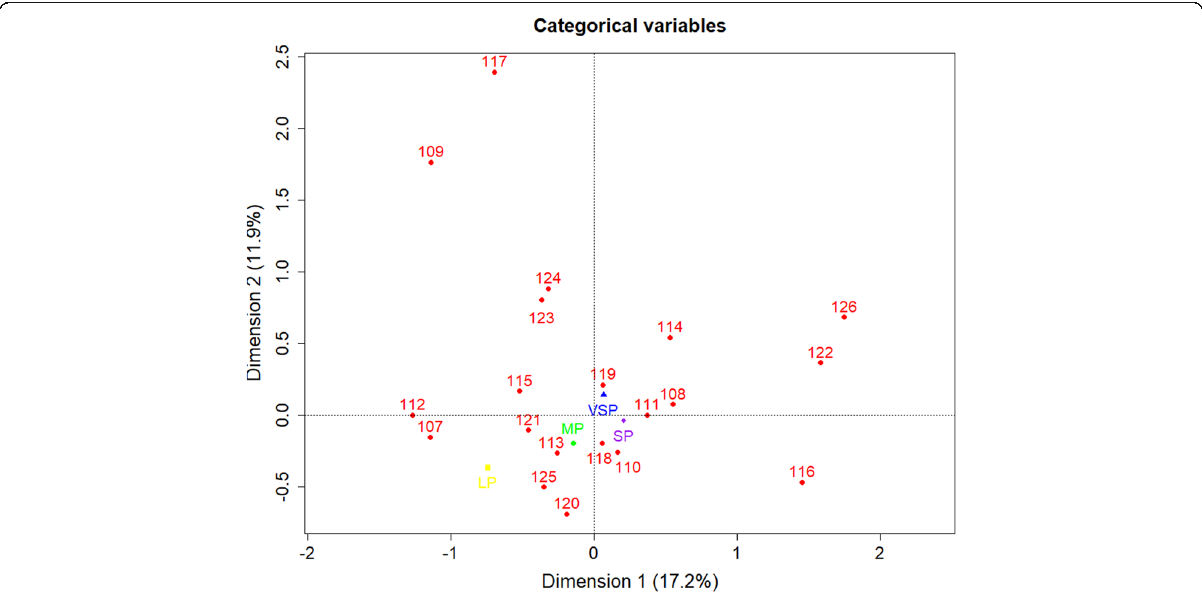
Fig. 6 Spatial projection of a categorical variables and b numerical variables for the component Environmental Information. Coding of